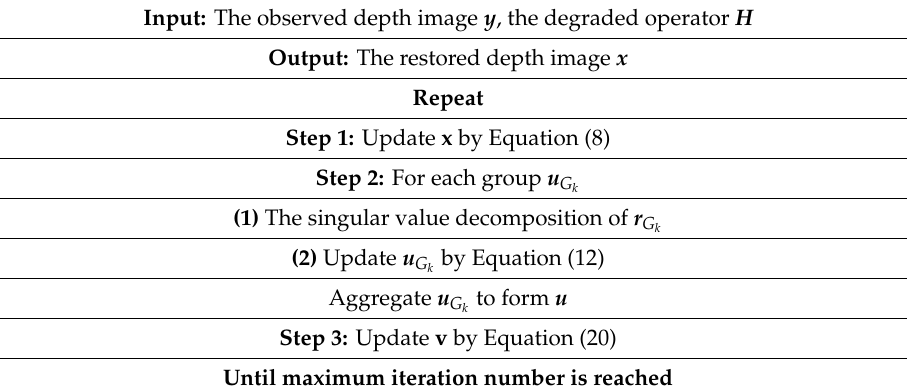
Table 1. Complete description of the proposed